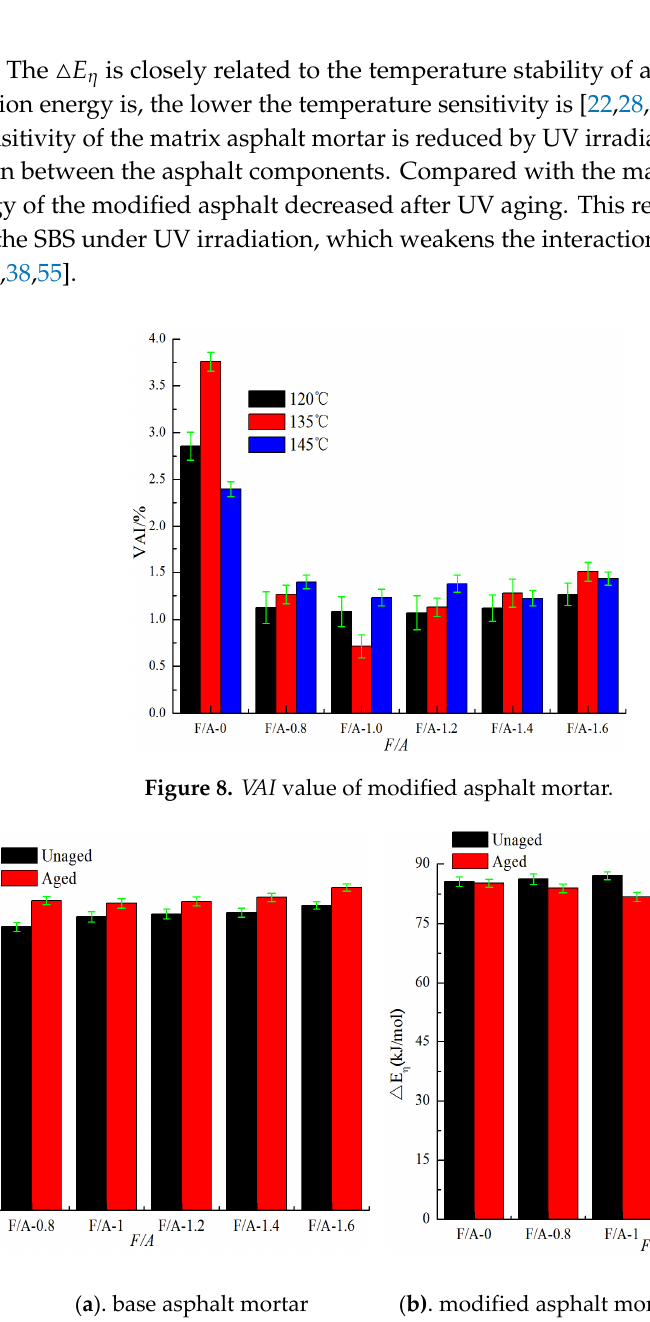
Figure 9. Activation energy about asphalt mortar before and after UV aging.